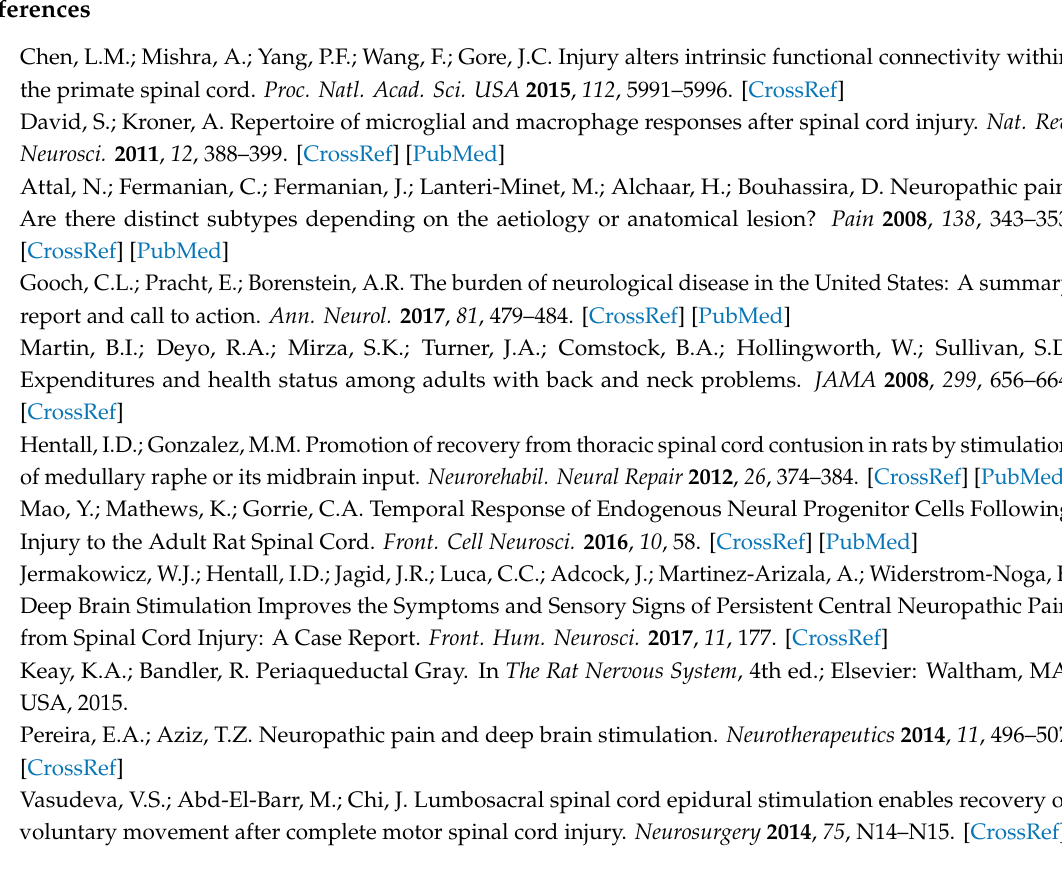
Table S1: List of antibodies and concentrations used; Supplemental; Table S2: Univariate and multivariate regression analyses with all three spinal cord subregions included in